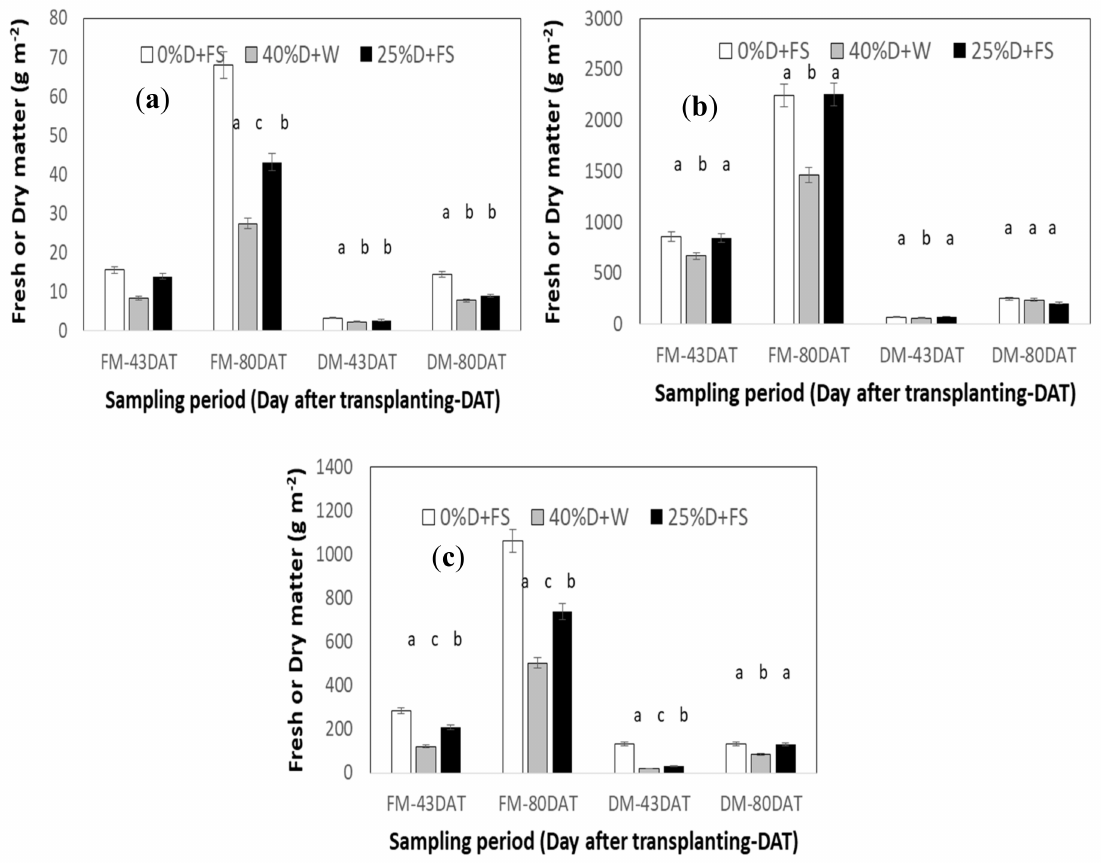
Figure 3. Mean fresh and dry weight in g m − 2 of secondary crops ( a ) rosemary, ( b ) basil and ( c ) peppermint 43 and 80 days after transplanting (DAT) during the 1st Period. The error bars represent the standard deviation of the means. Di ff erent letters within DAT indicate statistically significant di ff erences ( p <